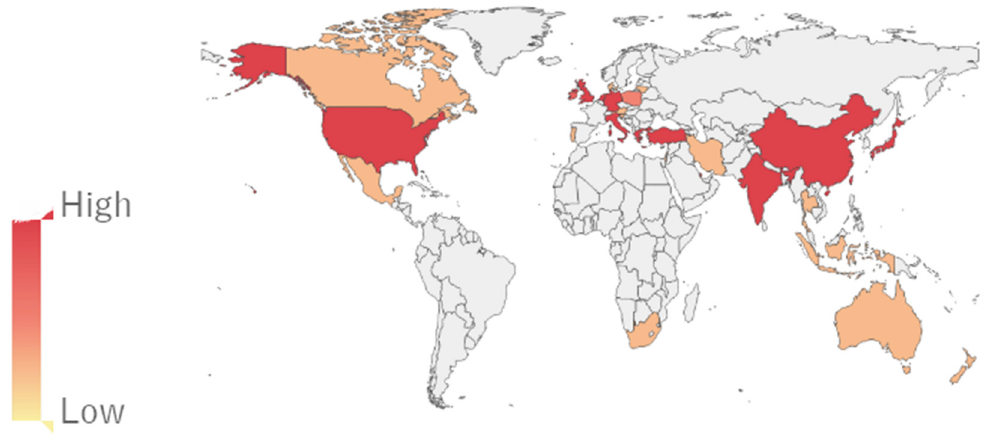
Figure 2. Worldwide research status of PRP in foot and ankle fi elds.